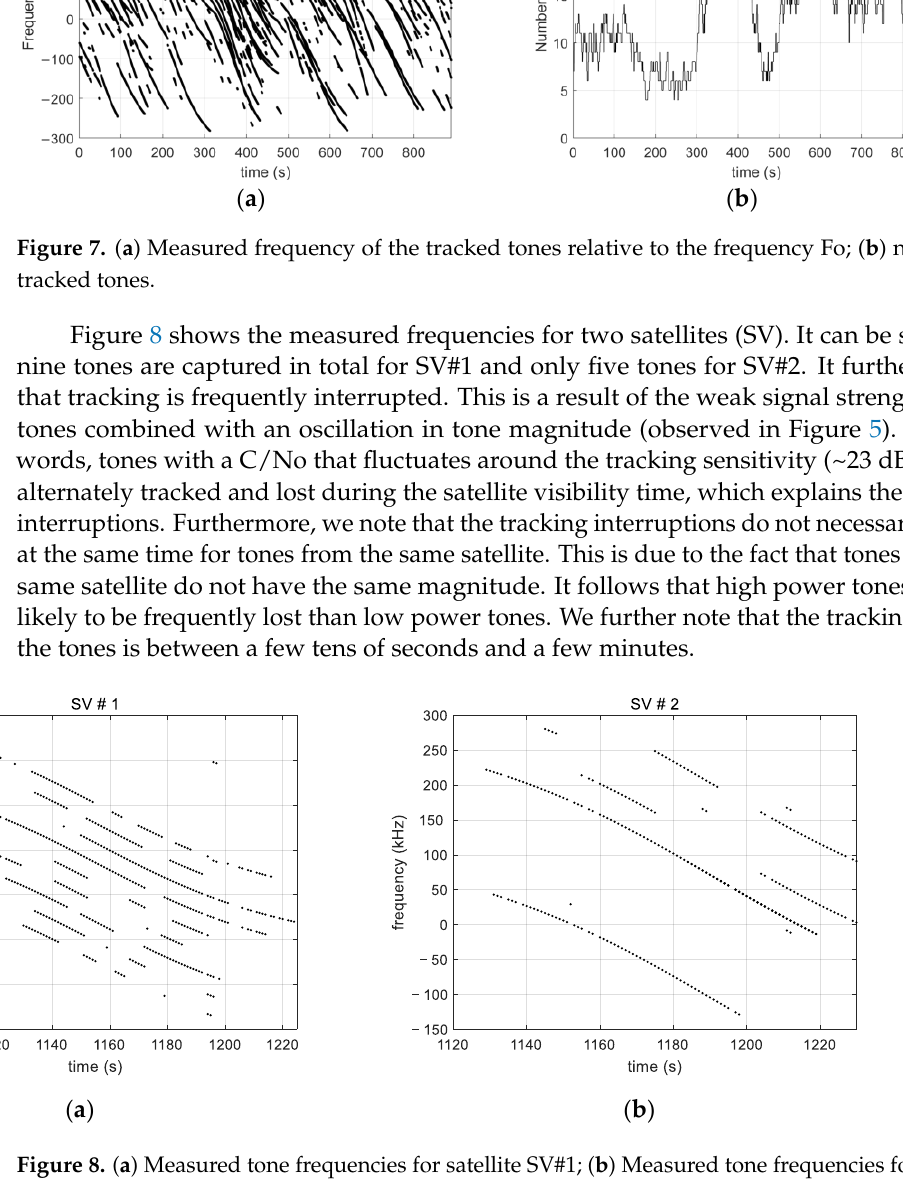
(1) 𝑓 𝑑𝑜𝑝𝑝𝑙𝑒𝑟𝑘 is the Doppler shift of the k th-satellite relative to 𝐹𝑜 , 𝑓 𝑟𝑥 is the receiver clock drift ( 𝛿𝑡̇ ) multiplied by 𝐹𝑜 , 𝑓 𝑠𝑣𝑘 is the k th-satellite clock drift ( 𝛿𝑡̇ 𝑘 ) multiplied by 𝐹𝑜 ,